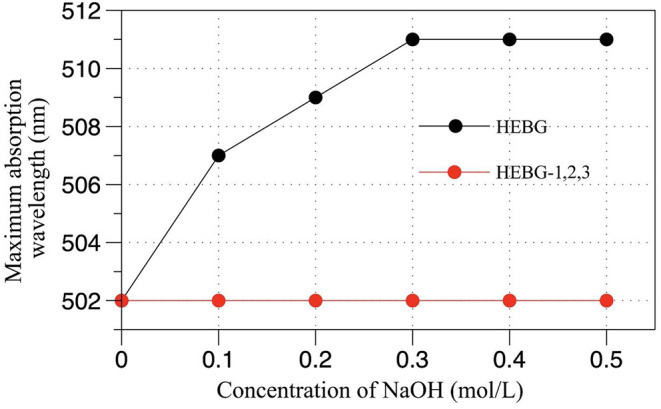
Effect of NaOH concentration on maximum absorption wavelength of Congo red-BCP complex.